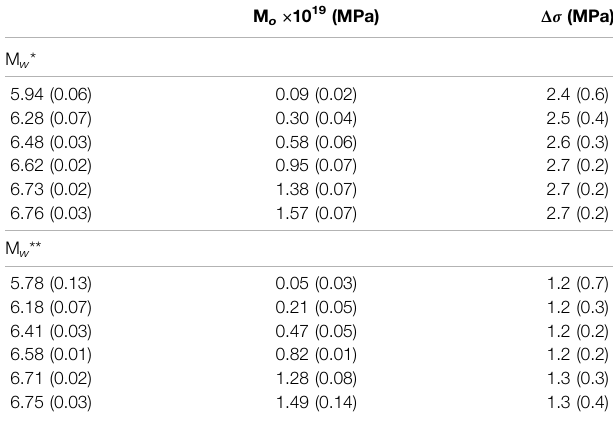
TABLE6| Valuesofstressdrop Δ σ correspondingthemomentmagnitudesM w of earthquakesfrom Table5 .*for faultsegmentwithpurestrike-slip kinematics. ** for fault segment with purenormal slipkinematics. Theseismic moment M o was derived from the moment magnitude M w of each earthquake via Eq. 11 (Hanks and Kanamori, 1979) which gives seismic moment in dyn cm, converted to MPa (1 dyn cm (cid:1) 1 × 10 − 7 MPa) and substituted into Eq. 12 . 1 σ errors are reported in